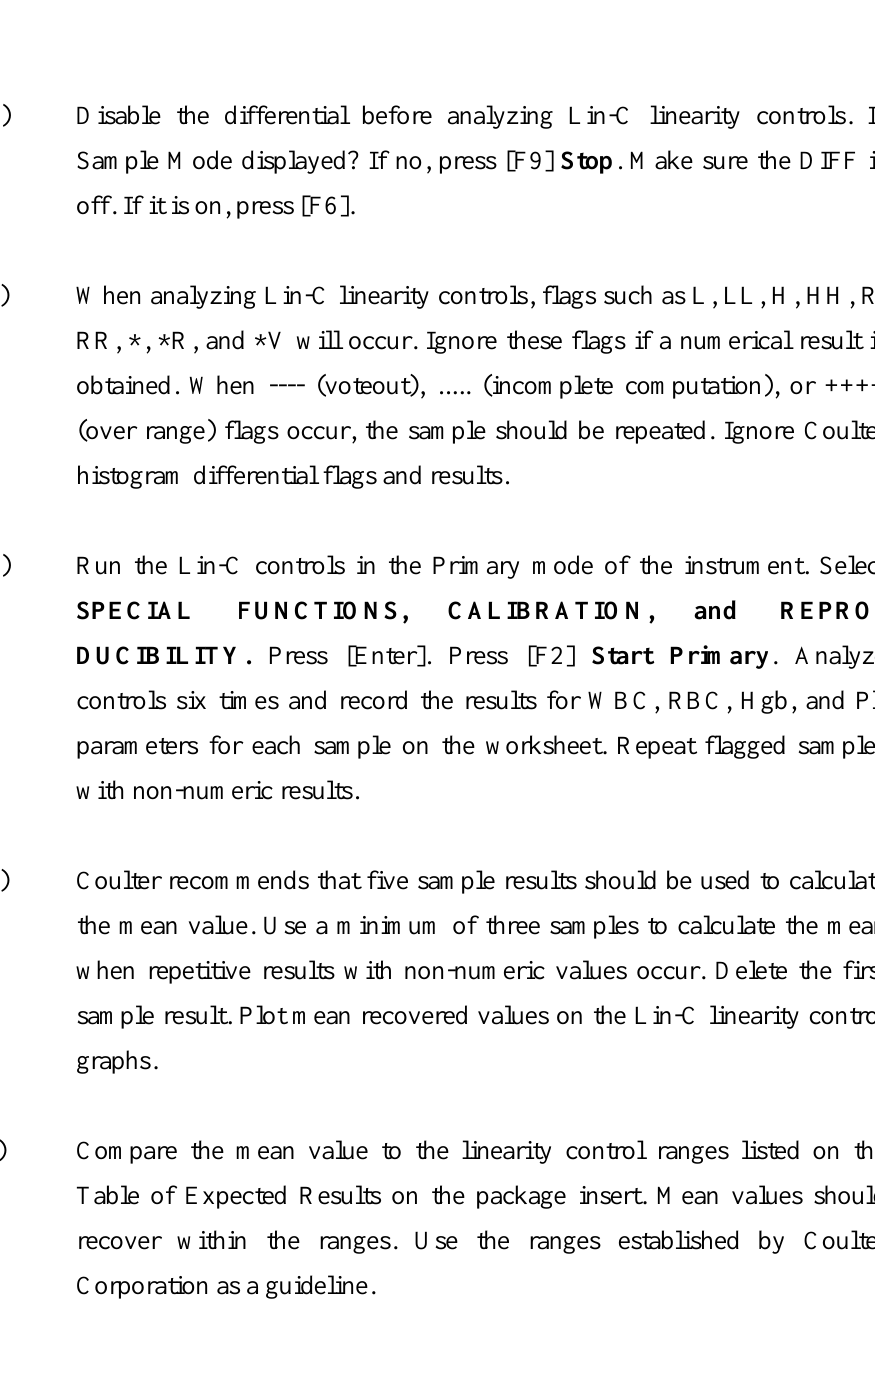
Table of Expected Results on the package insert. Mean values should recover within the ranges. Use the ranges established by Coulter Corporation as a